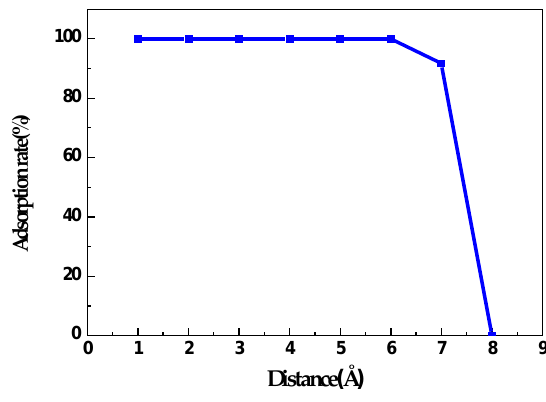
Figure 5. Variation of adsorption rate with distance.